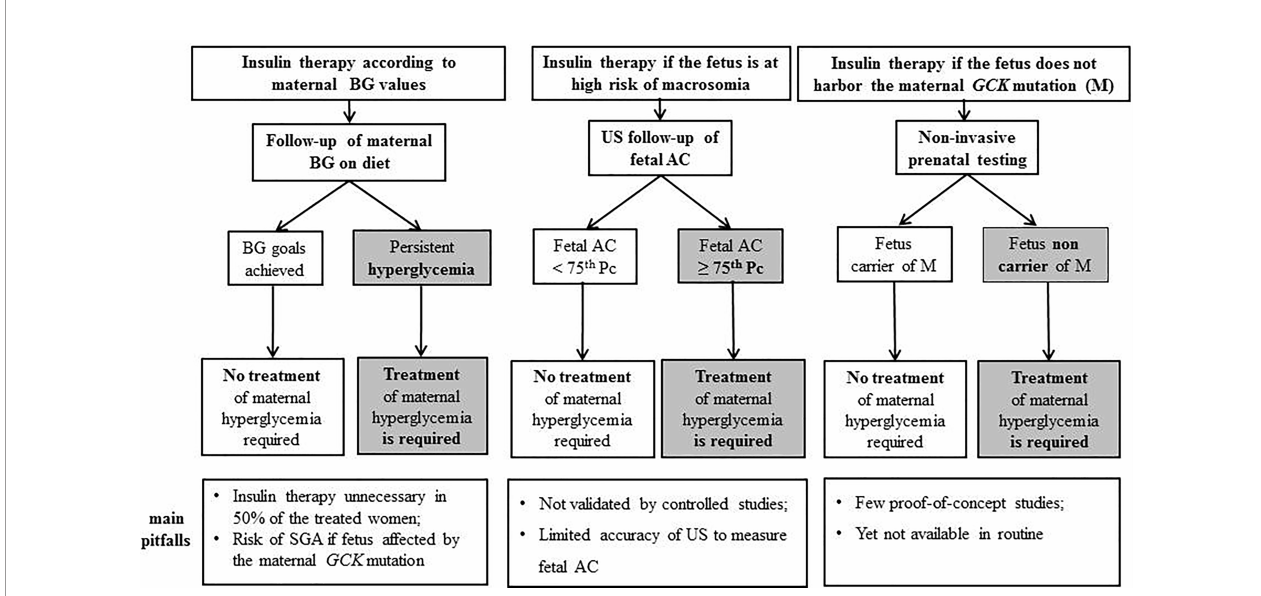
FIGURE 1 | Suggested algorithms to initiate insulin therapy in pregnant women with GCK -MODY. The left part of the fi gure describes the approach based, as in “ common ” gestational diabetes, on maternal blood glucose (BG) values. The middle part illustrates current recommendations, based on the serial measurement of fetal abdominal circumference (AC) by ultrasounds (US), and initiation of insulin therapy when AC is ≥ 75 th percentile (Pc), which suggests the absence of the maternal GCK mutation in the fetus and a risk of macrosomia. In the right part, initiation of insulin therapy will be based on the absence of the maternal mutation (M) in the fetus, diagnosed by non-invasive prenatal testing. The bottom part of the fi gure indicates the main pitfalls of each strategy. SGA, small for gestational